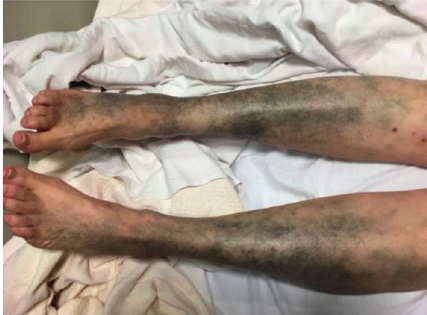
Figure 1: Bilateral legs with pigmentary changes.